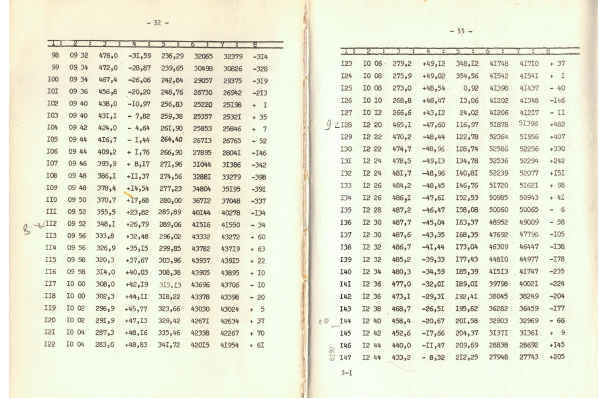
Figure 3. A sample page of the Kosmos-49 catalog (Dolginov et al.,